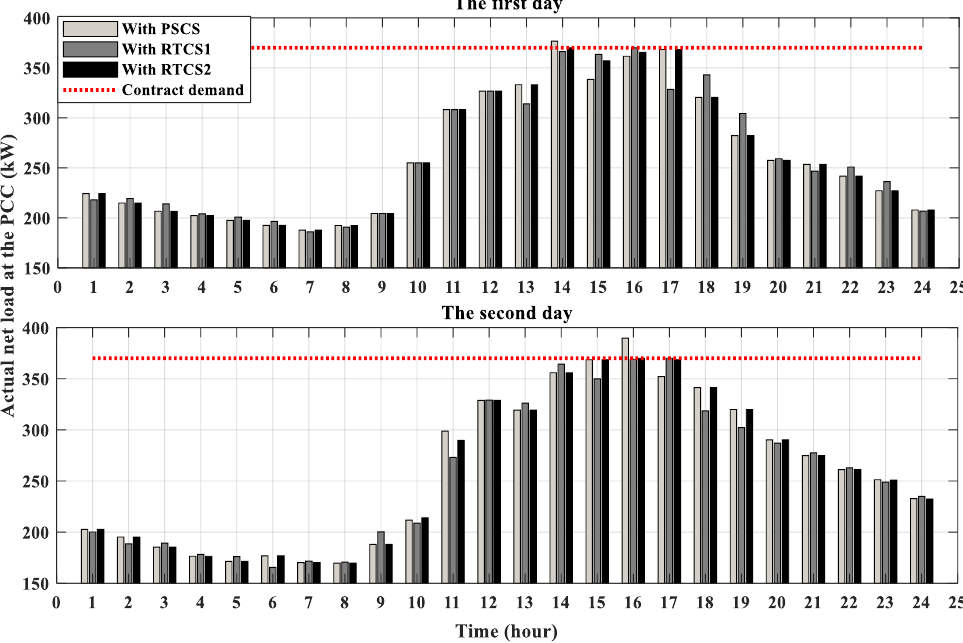
Figure 9. Actual net flow at PCC considering BESS operation with different control schemes.